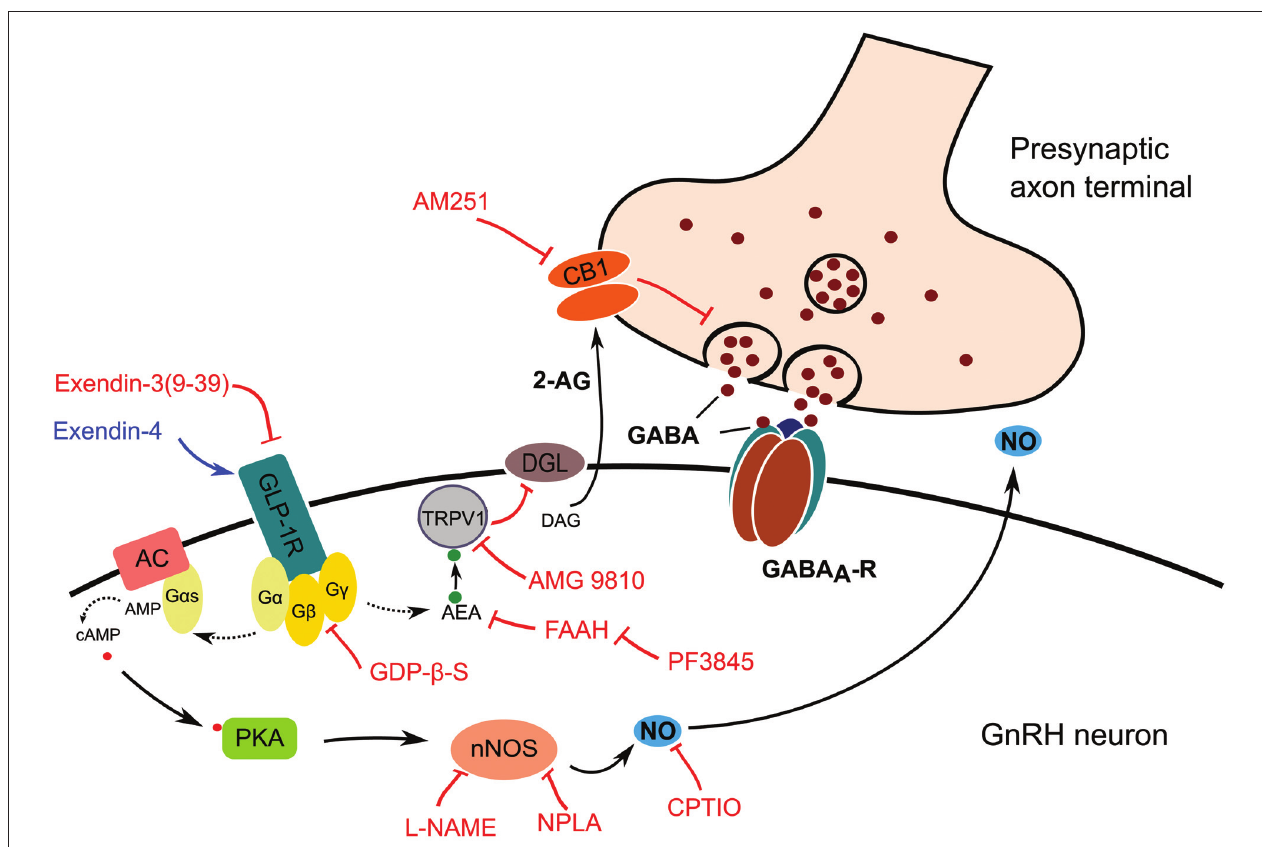
FIGURE 8 | Schematic illustration of GLP-1R signaling in GnRH neurons and its proposed action on presynaptic GABA release . Effect of the GLP-1R agonist (Exendin-4) or antagonist (Exendin-3) is mediated by G-protein complex, which may activate two retrograde signaling cascades. The first pathway involves activation of the intracellular TRPV1 which decreases postsynaptic production and release of 2-AG resulting in the suppression of inhibition of the presynaptic GABA release. The second one involves the release of NO produced by nNOS which increases the release probability and vesicular reuptake of GABA at the presynaptic terminal. Abbreviations: GLP-1R, glucagon-like peptide 1 receptor; AC, adenylate cyclase; G α , G β , G γ , G-protein subunits; DAG, diacylglycerol; DGL, DAG-lipase; CB1, cannabinoid receptor type-1; AM251, CB1 antagonist; 2-AG, 2-arachidonoylglycerol; GABA A -R, GABA A receptor; PKA, protein kinase A; nNOS, neuronal